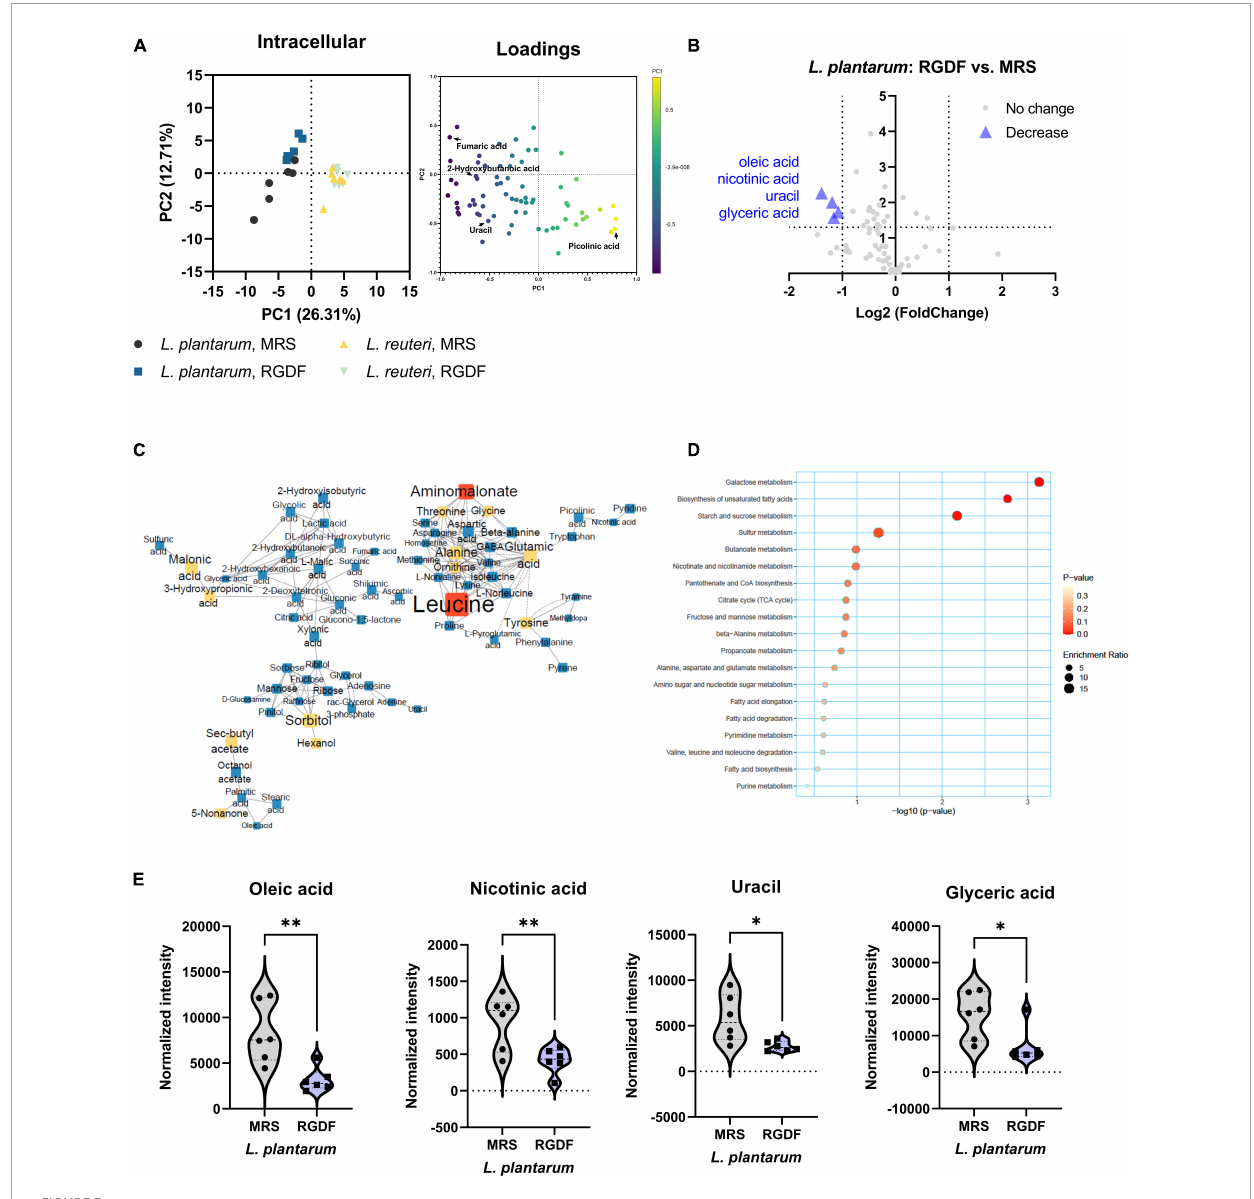
FIGURE3 Intracellular metabolomic analysis of L. plantarum and L. reuteri cultured with 0.5% (w/v) RGDF compared to the control MRS broth. (A) Principle component analysis (PCA) score and loading plots. (B) Volcano plot of L. plantarum . Significantly decreased metabolites are indicated by blue triangles. (C) MetaMapp of L. plantarum culture with RGDF compared to the control MRS broth. Each node is a structurally identified metabolite. Blue nodes are decreased metabolites, and yellow nodes are unchanged metabolites. The size of nodes and labels reflect fold-changes and p -values by t -test, respectively. (D) MSEA of L. plantarum . (E) Normalized abundance of intracellular metabolites of L. plantarum cultured with 0.5% (w/v) RGDF compared to the control MRS broth. Data are expressed as violin plots of six determinations. Differences between metabolite abundances were all significant at a significance level of 95% ( ∗ ) and 99% ( ∗∗ ), as determined by the Student’s t -test.